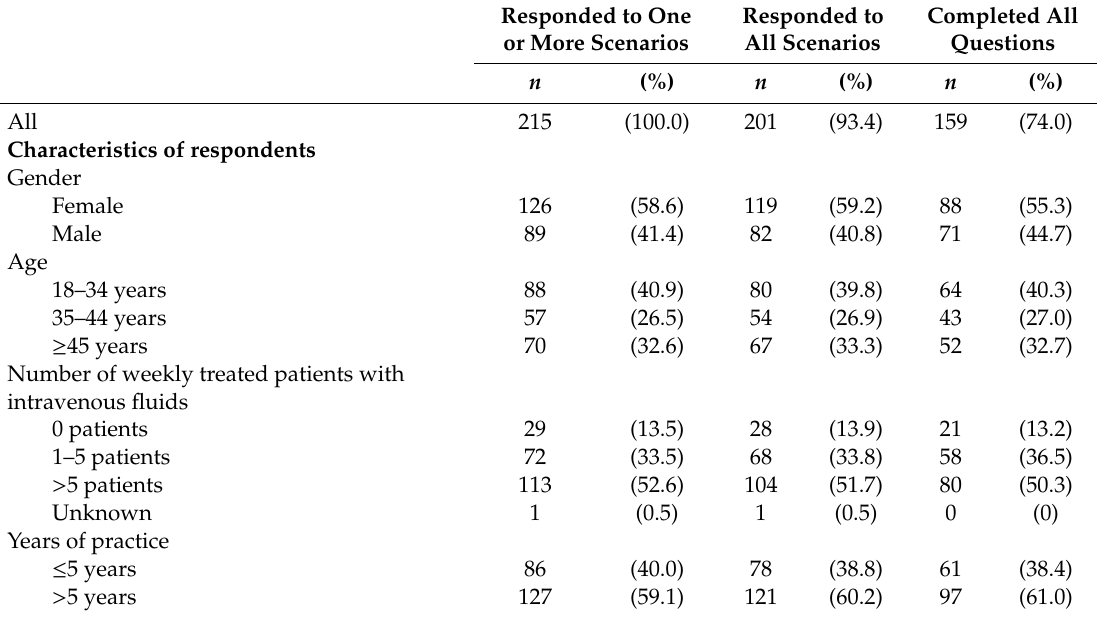
Table 2. Characteristics and distribution of physicians indicating gender, age, number of weekly treated patients with intravenous fluids, years of practice and position, and characteristics of hospitals/emergency departments (EDs) indicating location (region), size, complexity, and patient type served .